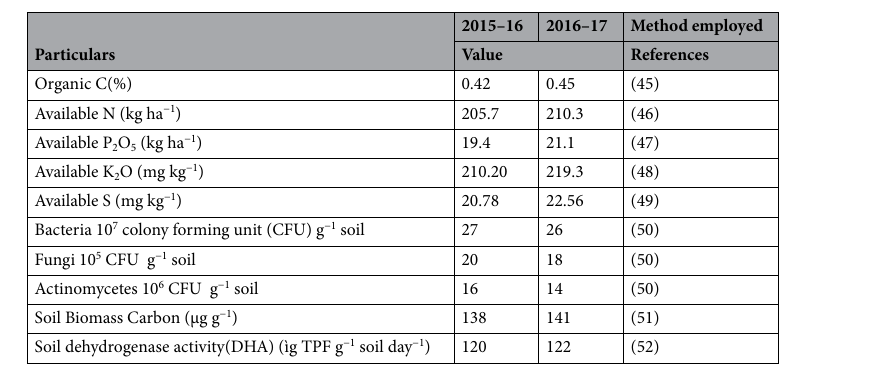
Table 5. Initial soil chemical and biological